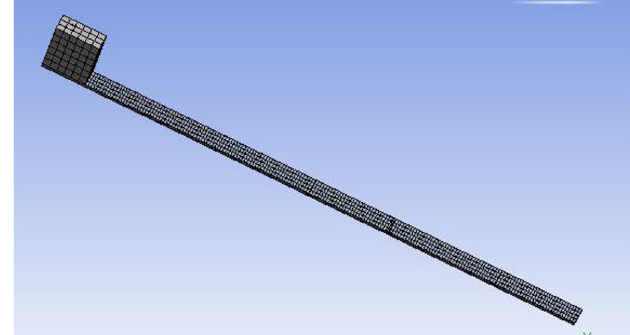
Fig. 3. FEA model for the moving load problem for Fig. 2. Laboratory test model for simply supported structure. Table 1. Frequency ratio for the cracked beam at different